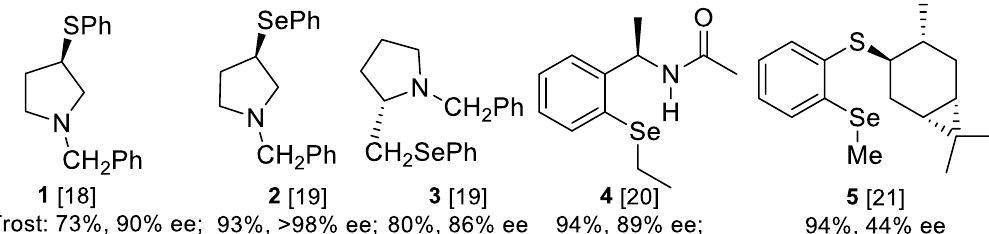
Figure 1. Examples of nitrogen-sulfur and selenium chiral ligands.